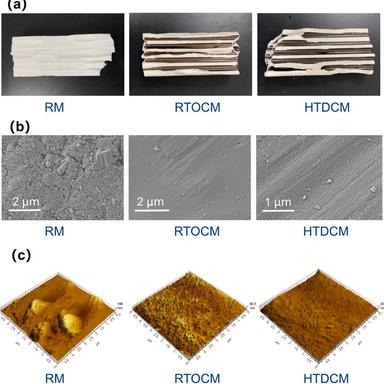
(a) Photographs of RM, RTOCM, and HTDCM. (b) FESEM micrographs of RM, RTOCM, and HTDCM. (c) 3D morphological images of the surfaces of RM, RTOCM, and HTDCM.